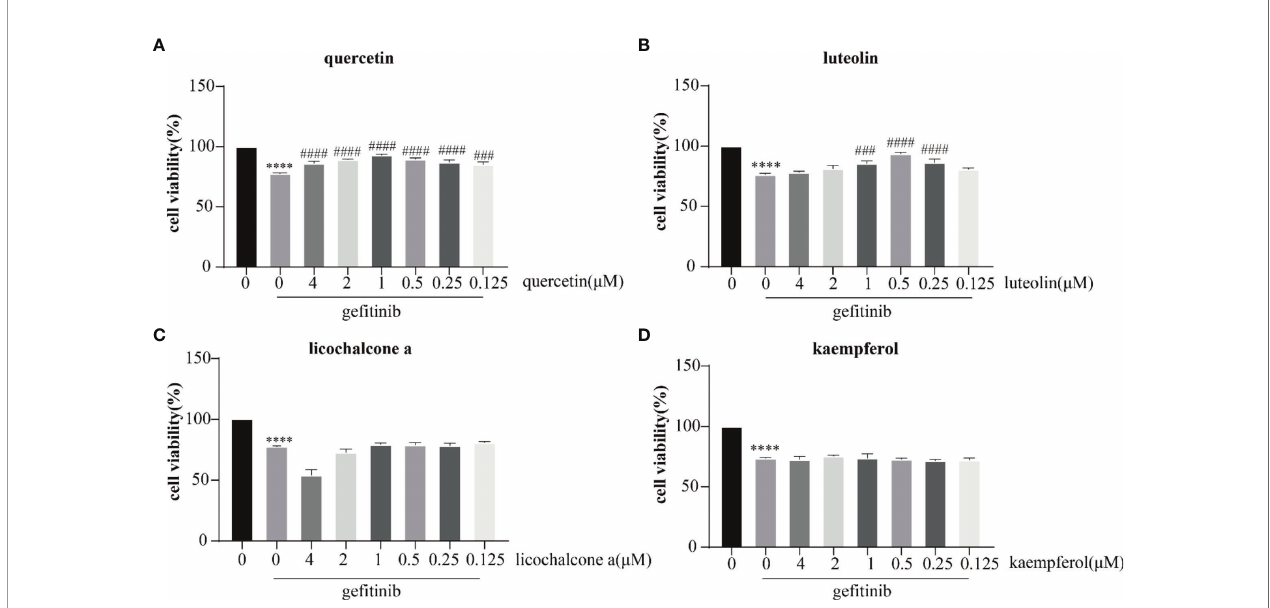
FIGURE 9 | Inhibitory effects of quercetin (A) luteolin (B) licochalcone a (C), and kaempferol (D) on the proliferation of HaCaT cells. The drug concentration – cell viability curve was generated on the basis of cell viability data. All data were expressed as the mean ± SD. “ * ” compared with Control (The fi rst pillar), ****p < 0.0001. “ # ” compared with Ge fi tinib (The second pillar), ### p < 0.005, #### p <